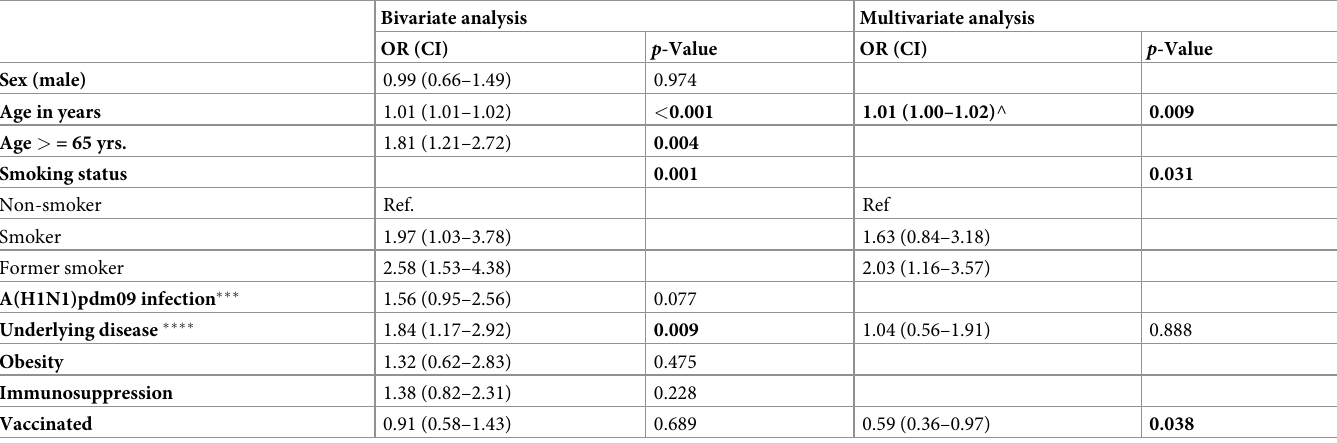
Table 4. Bivariate and multivariate analysis of factors associated with severe influenza-associated